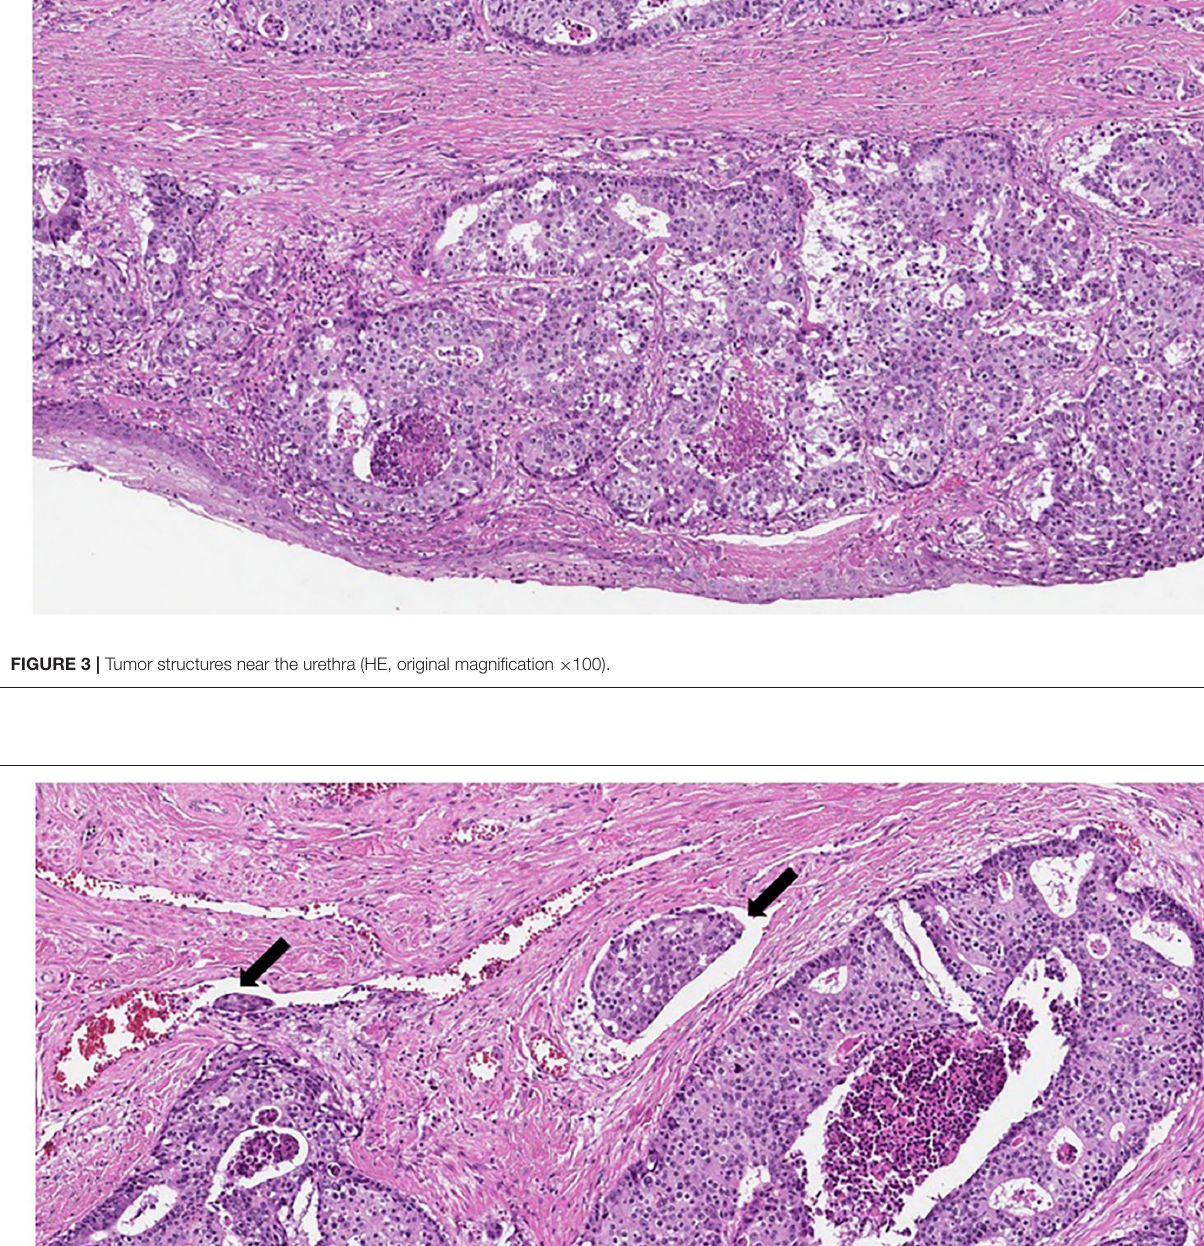
Frontiers in Surgery |